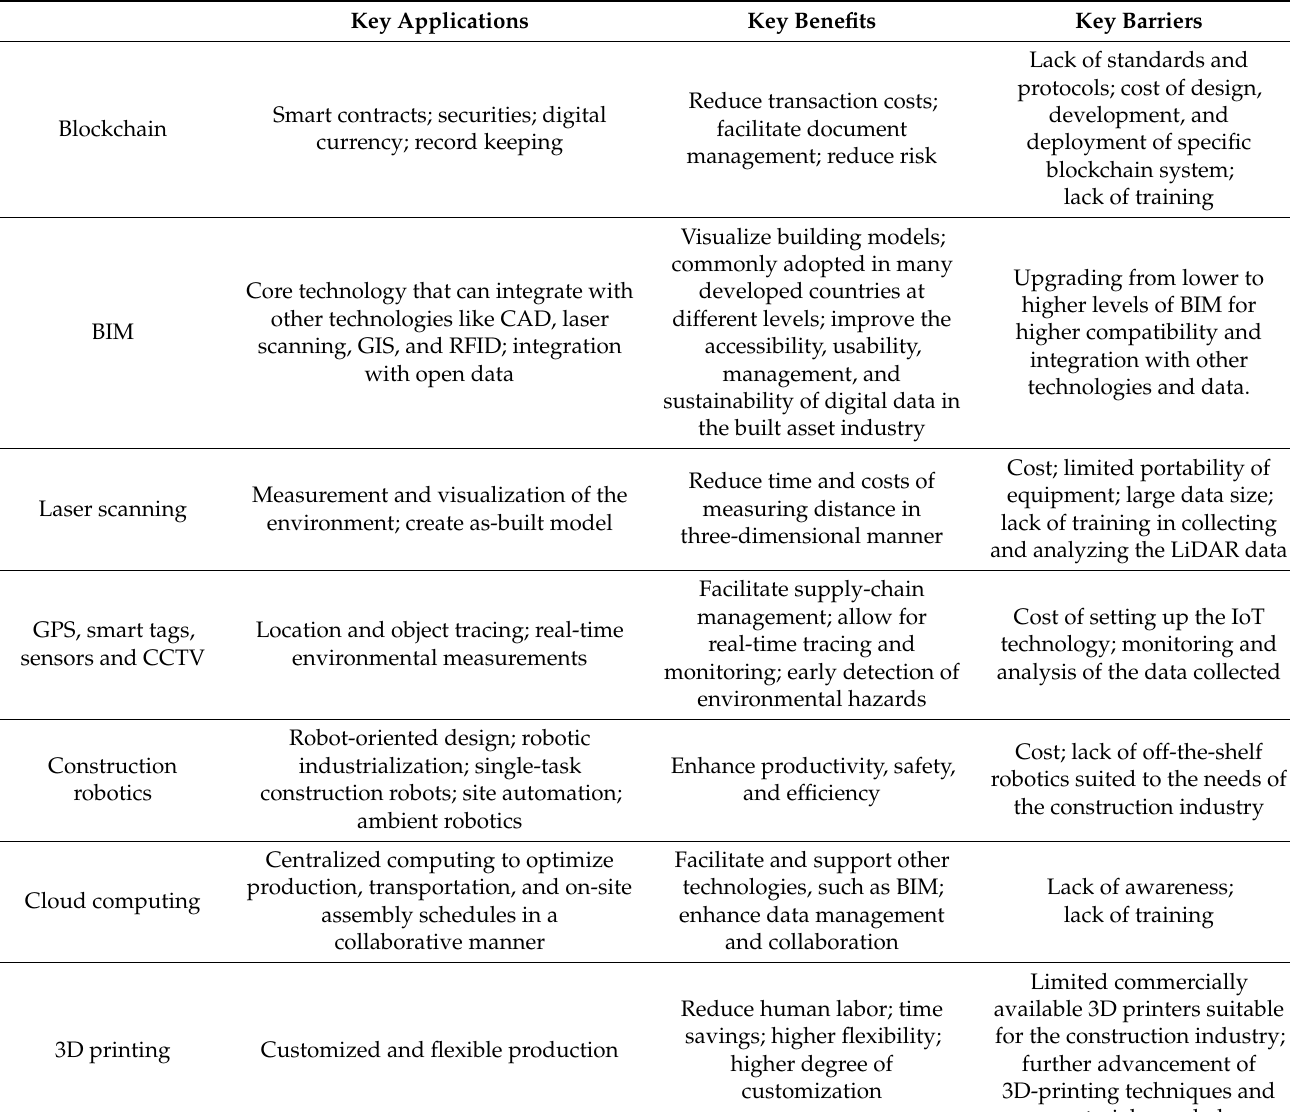
Table 1. A comparison table of smart technologies in MiC